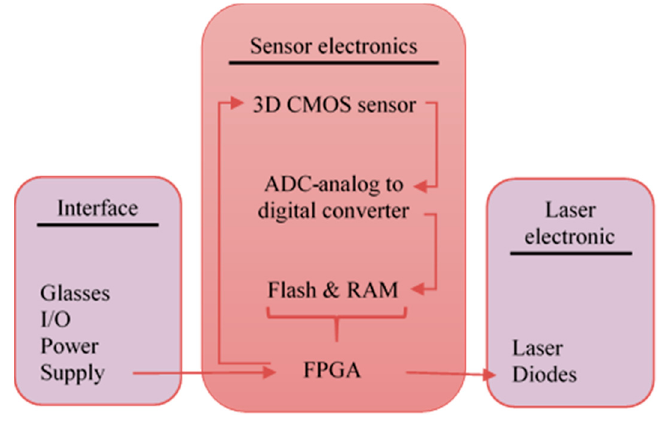
Figure 12. Design of the sensor module [31].